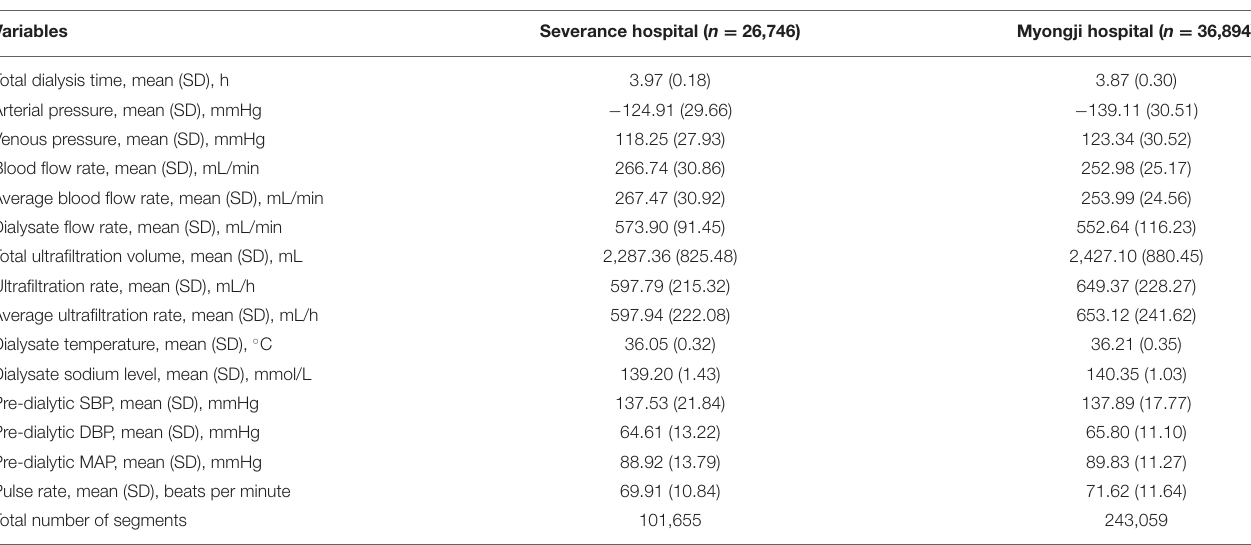
TABLE 1 | Characteristics of the study